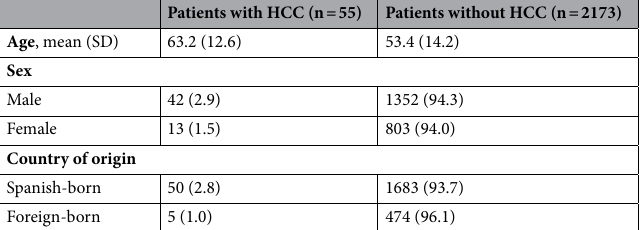
Table 3. Description of patients with and without HCC who presented late to care. Spain, 2018/2019. Missing values not reported. HCC hepatocellular carcinoma.